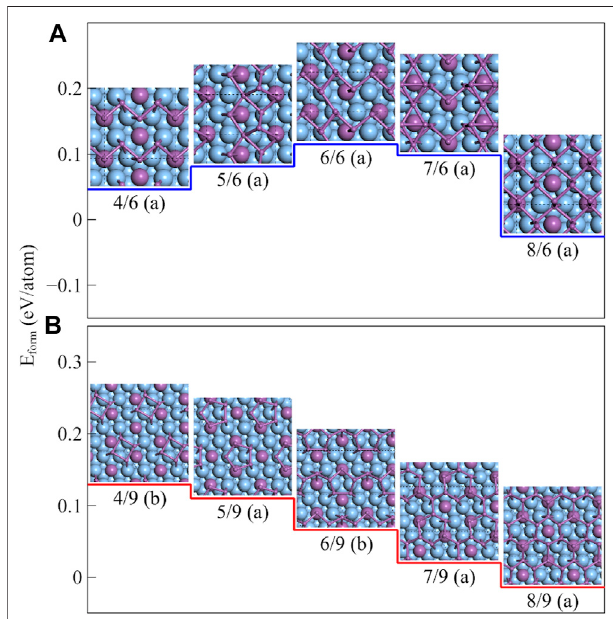
(cid:1)(cid:1) √ 3 and 3×3 supercell